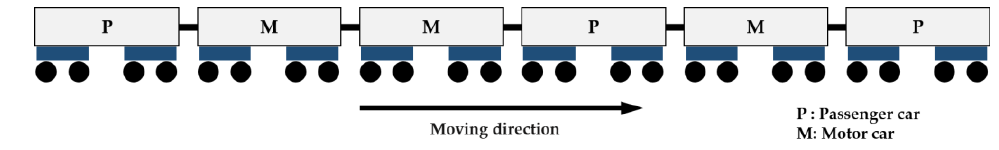
Figure 6. The urban railway trainset of six cars.